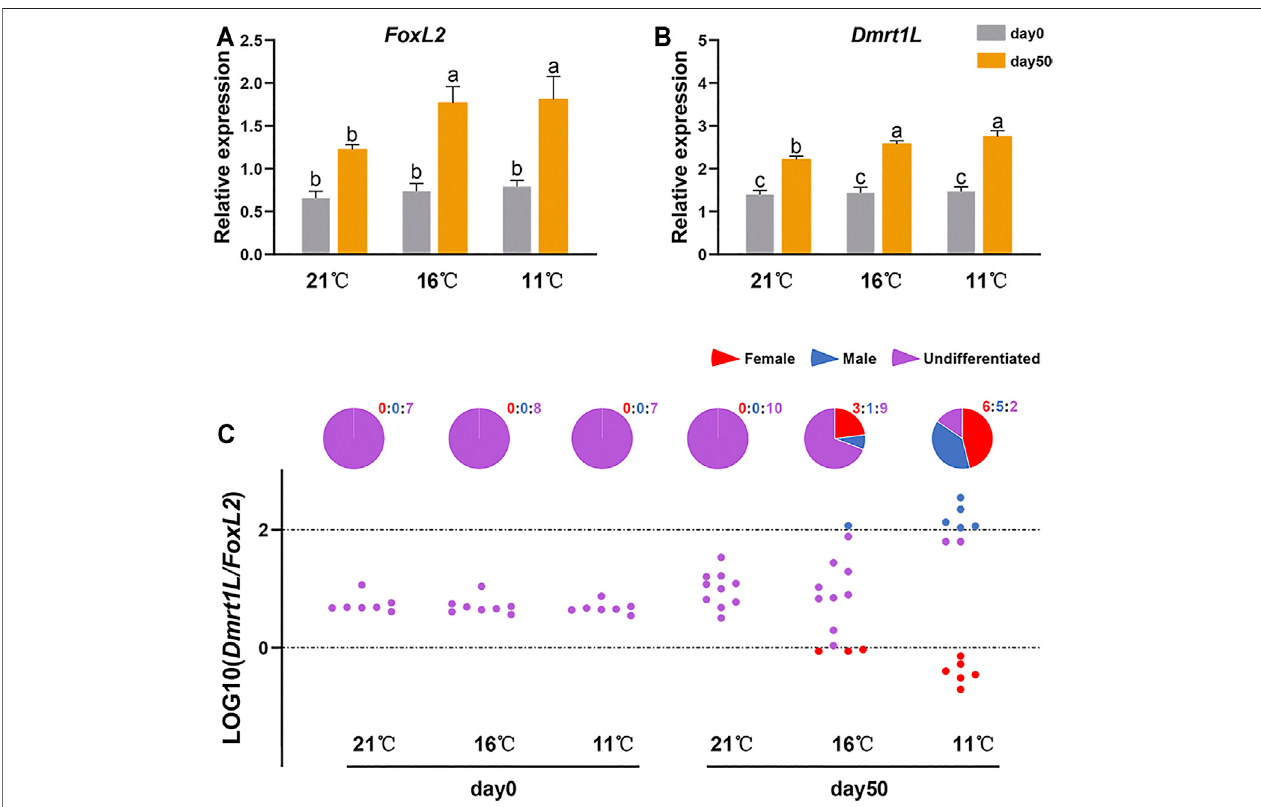
FIGURE4| Relativeexpressionof FoxL2 and Dmrt1L inthethreetemperaturegroupsatday0and50.Relativeexpressionlevelsof FoxL2 (A) and Dmrt1L (B) inthe three temperature groups (21, 16 and 11 ° C) at day 0 and 50. The vertical bars represent the means ± SEM (N (cid:1) 7 – 13). Different letters indicate signi fi cant differences ( p < 0.05). (C) The LOG10( Dmrt1L / FoxL2 )values and sexdifferentiationratioforeachgrouponday0and50.Eachdot representsasample.Thedashedlinesindicate thethresholdforsexdifferentiation,withvaluesbelow0forovaryandvalueshigherthantwofortestis.Thepiechartsindicatethepercentagesoffemale(red),male (blue) and undifferentiated samples (purple) in each month. The values above the pie charts are the corresponding numbers of female (red), male (blue) and undifferentiated samples (purple).